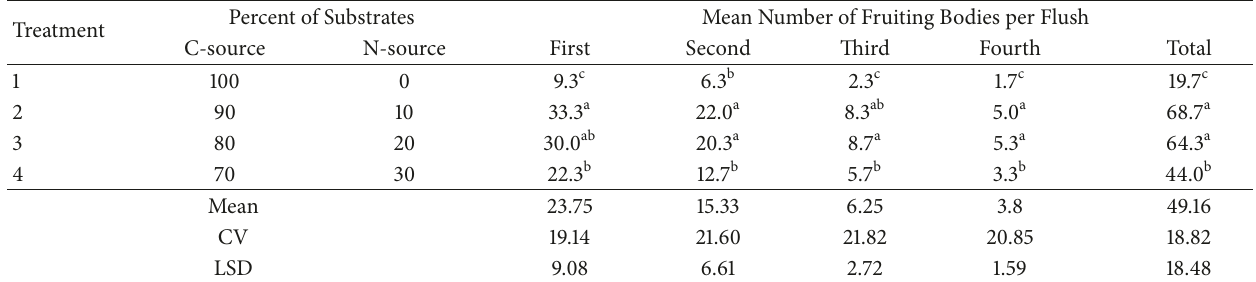
Table 3: Number of fruiting bodies of grey oyster ( P. sajor-caju ) mushroom.